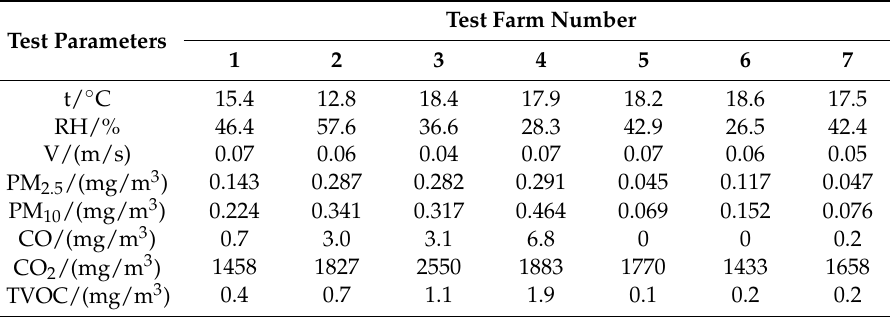
Table 2. Test results of various IAQ parameters.